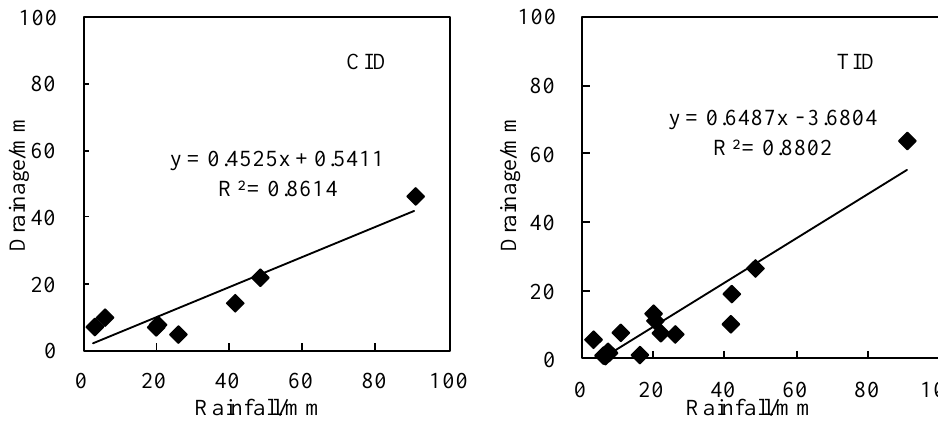
Figure 7. Regression analysis of rainfall and runoff using daily data.